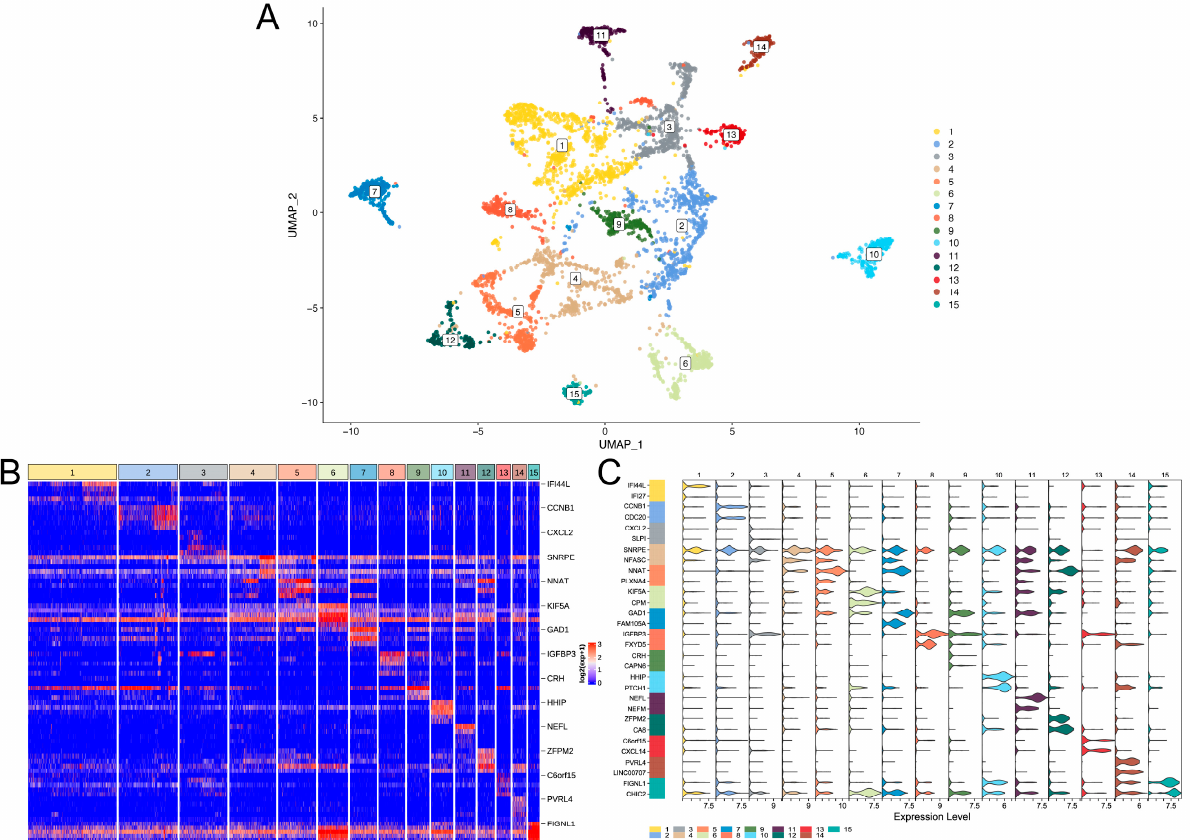
Figure 1. Unsupervised clustering of adult GBM cells. ( A ) UMap dimensionality reduction of clustering results. The X-axis and Y-axis represent the two dimensions of the UMap dimensionality reduction space. The points in the figure are cells, and all cells are colored separately according to the cluster labels. ( B ) The expression heat map of specific genes of cell clusters. Only the top five genes with significant differences in log2FC of each cell cluster are shown, and the gene name is annotated for the first gene. The upper color bar corresponds to each cell cluster. ( C ) Violin diagram of cell cluster-specific gene expression. The upper numeric label and the color bar on the left represent each cell cluster. The X-axis is the expression value, and the Y-axis is the gene. Only the top two genes with significant differences in log2FC of each cell cluster are shown.